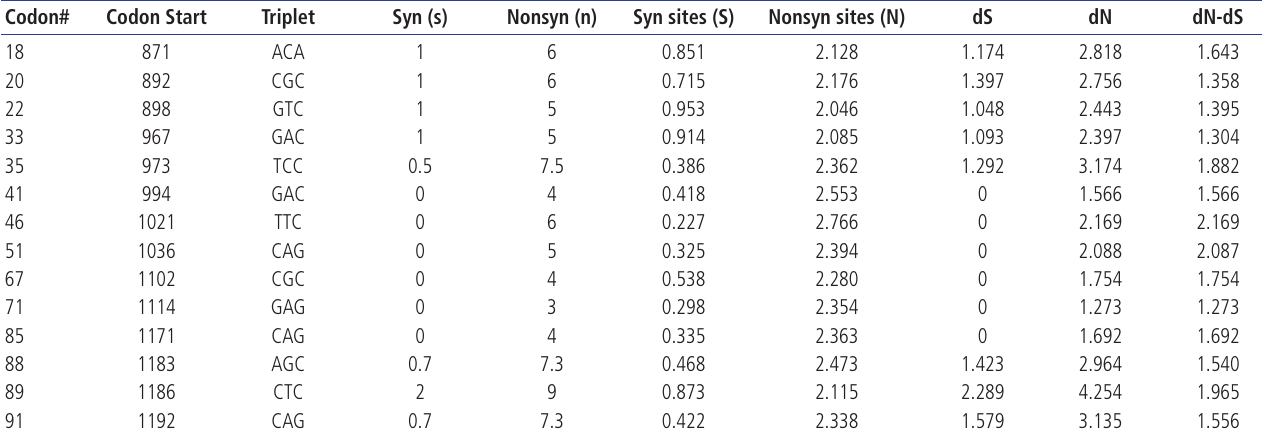
Table 4. Maximum likelihood analysis of natural selection codon-by-codon